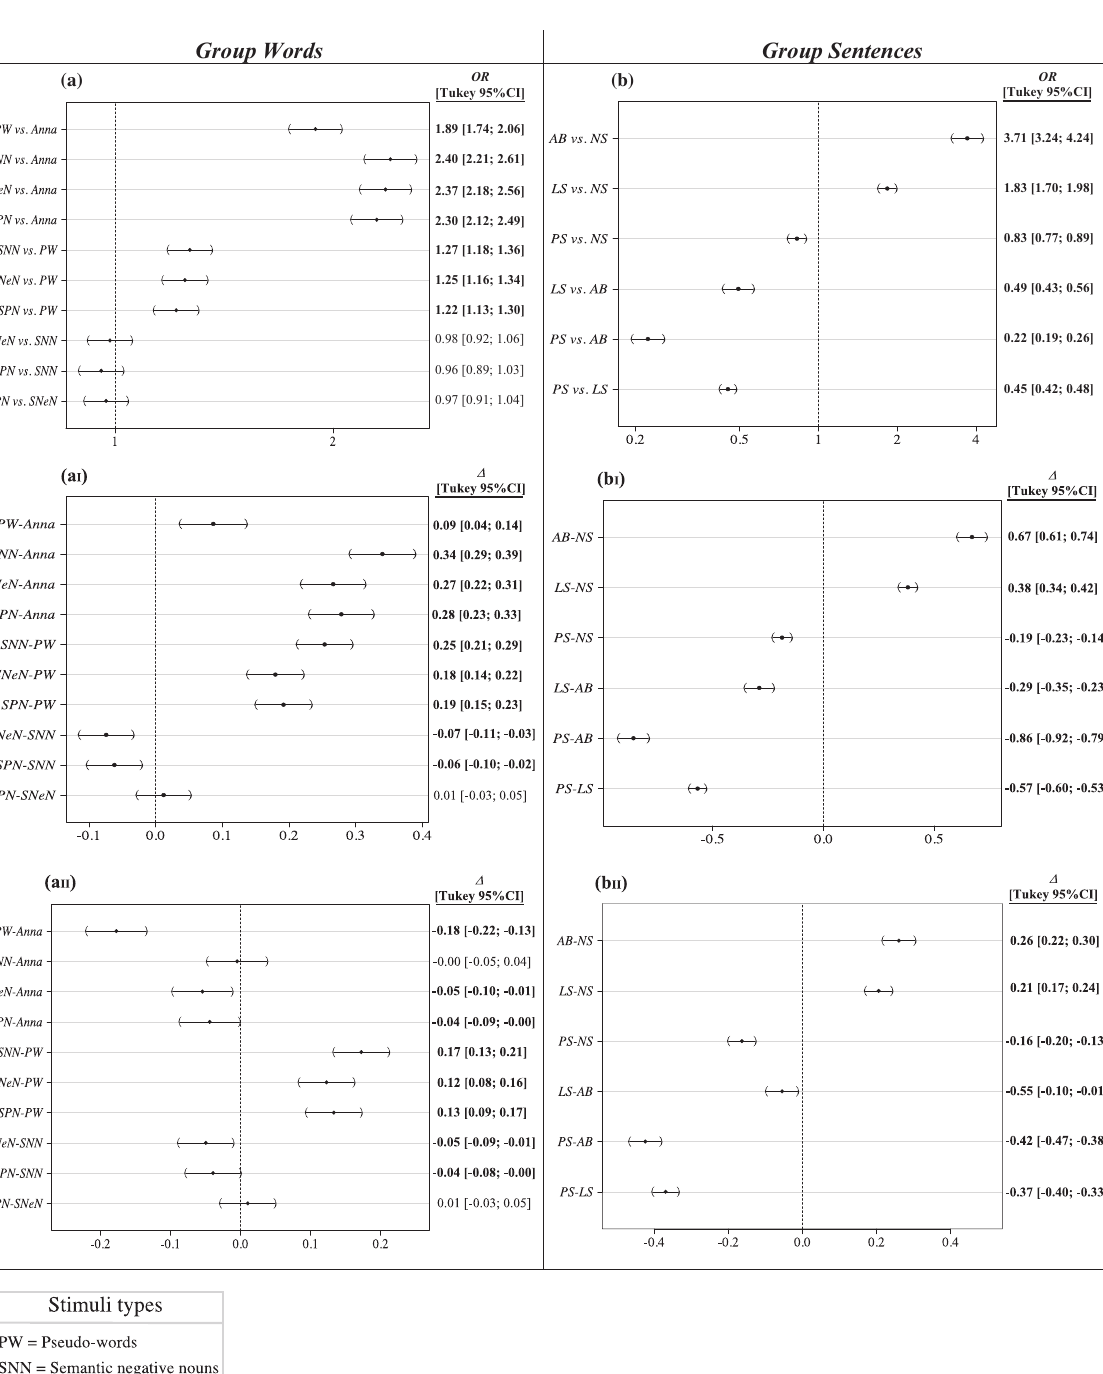
HUMANITIES AND SOCIAL SCIENCES COMMUNICATIONS|